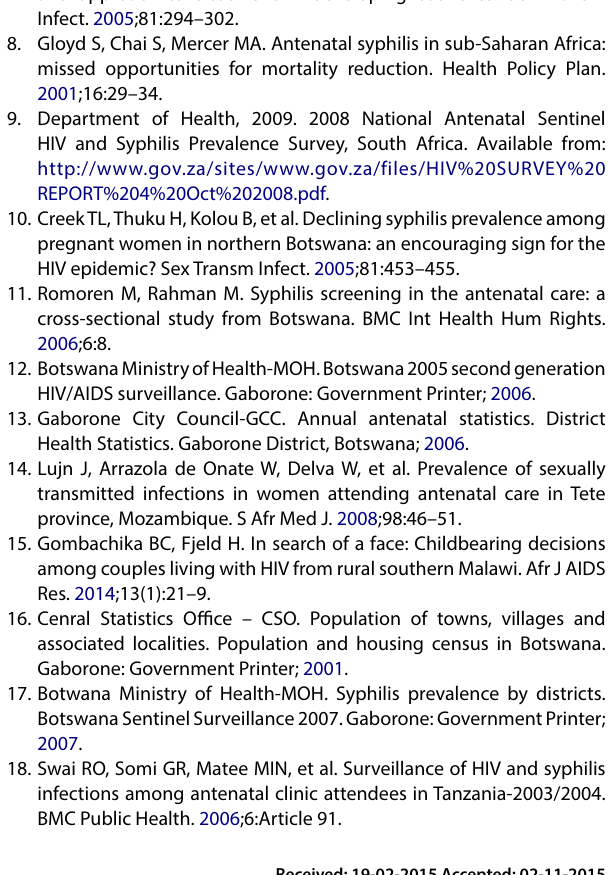
Figure 1: Trends in syphilis prevalence per total number of reactive VDRL/RPR by age group for combined clinics per year,